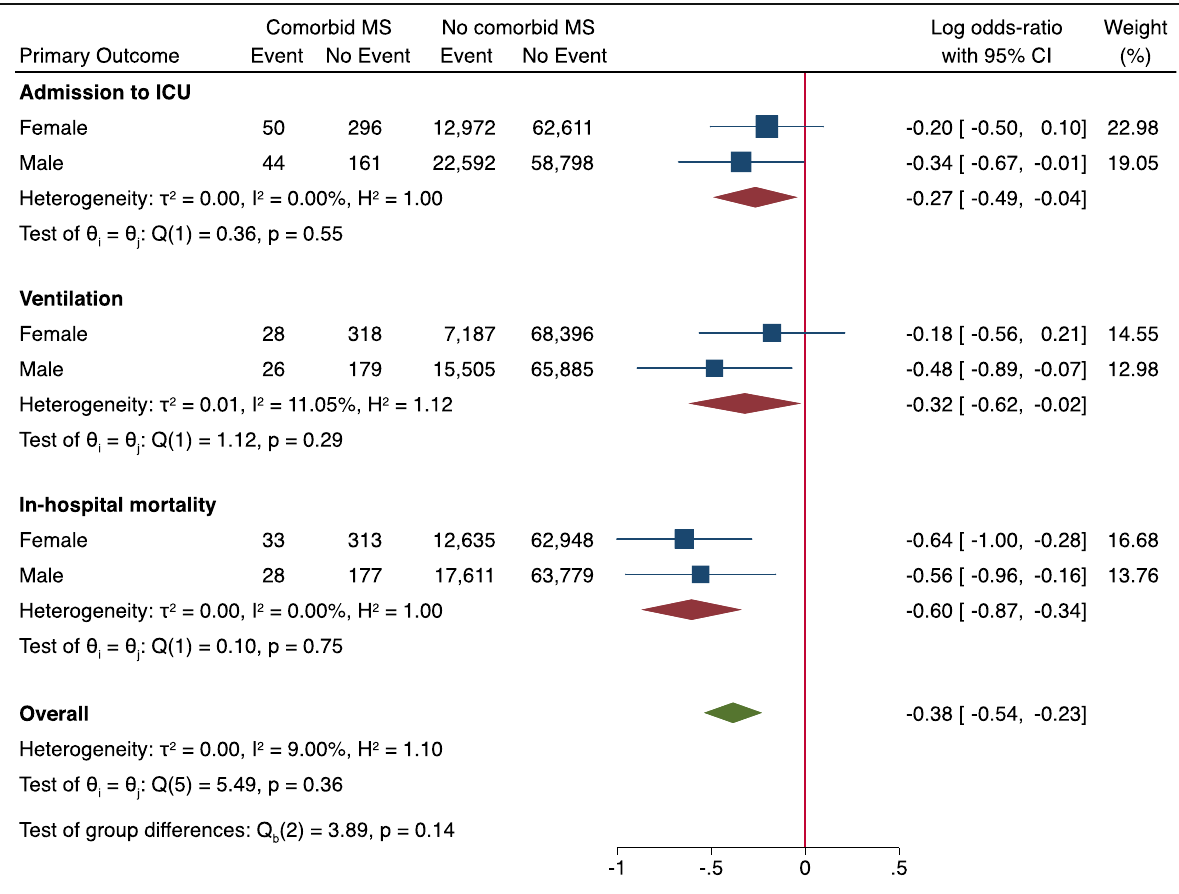
Fig. 1 Primary outcome parameters stratified by sex. Log odds-ratio < 0 indicate lower risk for patients with comorbid MS. Abbreviations: ICU = intensive care